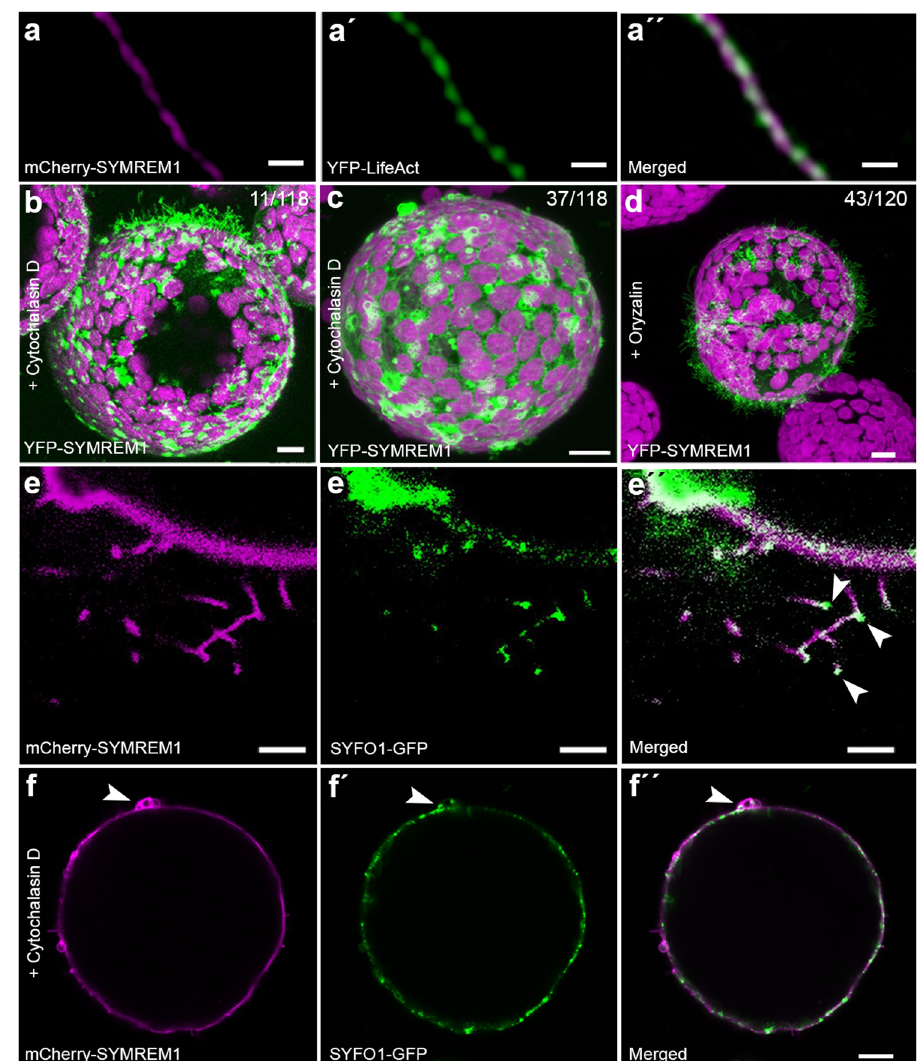
e – f ′′ N. benthamiana protoplasts ectopically expressing mCherry-SYMREM1 (magenta)developed multiplemembrane tubes witha tip localizedformin protein SYFO1 (green, white arrowheads, e – e ′′ ). SYFO1 remained to be recruited into membrane blebsafterCytochalasinD treatment oftheseprotoplasts (green, white arrowheads, f – f ′′ ). Scale bars indicate 10 μ m. Data were obtained from four inde- pendent biological